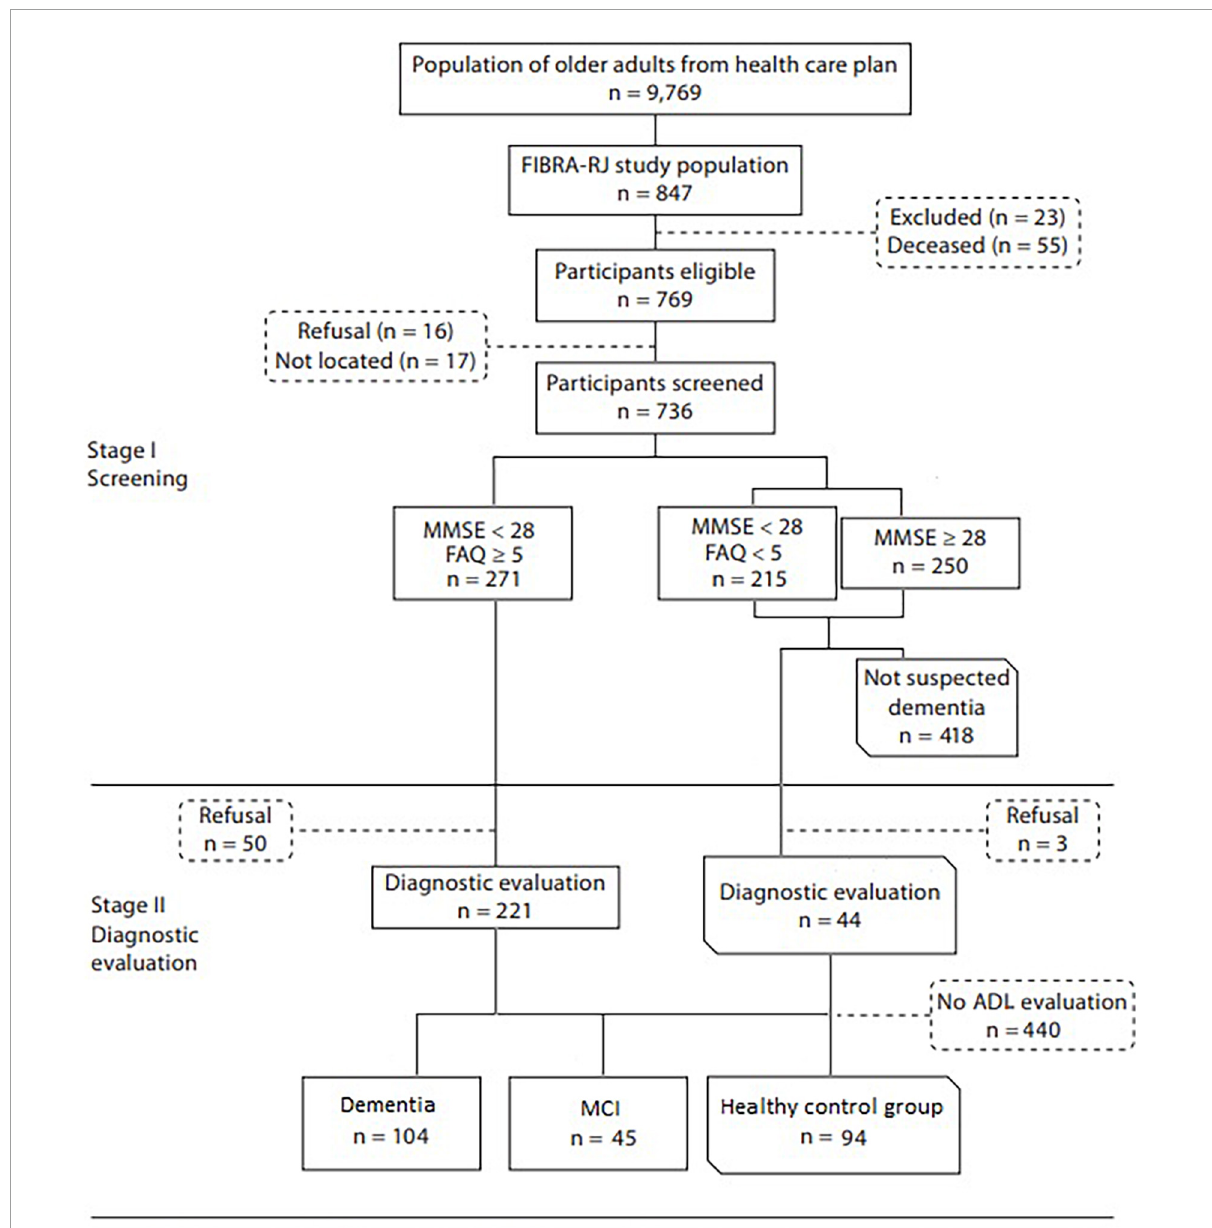
FIGURE1 Flowchart of the FIBRA study.